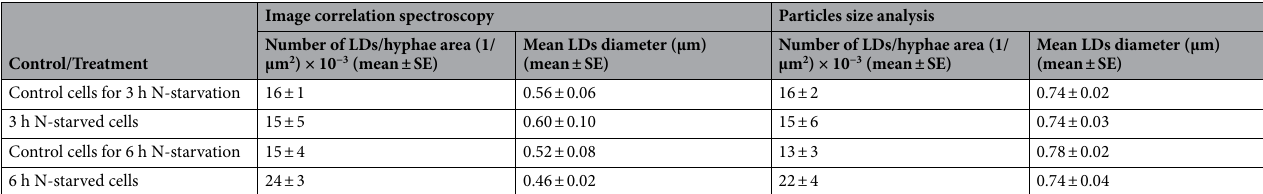
Table 1. A comparison of the number and size of lipid droplets obtained by the quantification analysis of the two methods, ICS and PSA. n = 3 for each group